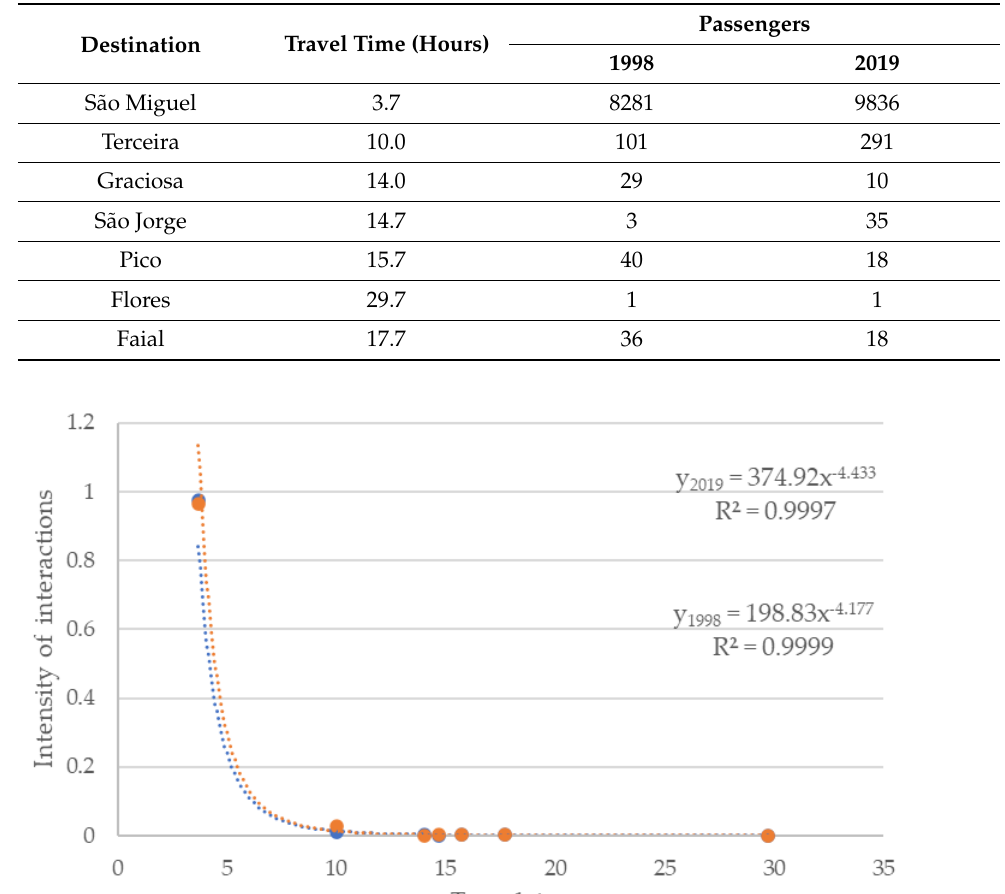
Table 8. Data for maritime connections to Santa Maria Island from the rest of the archipelago—for 1998 and 2019.